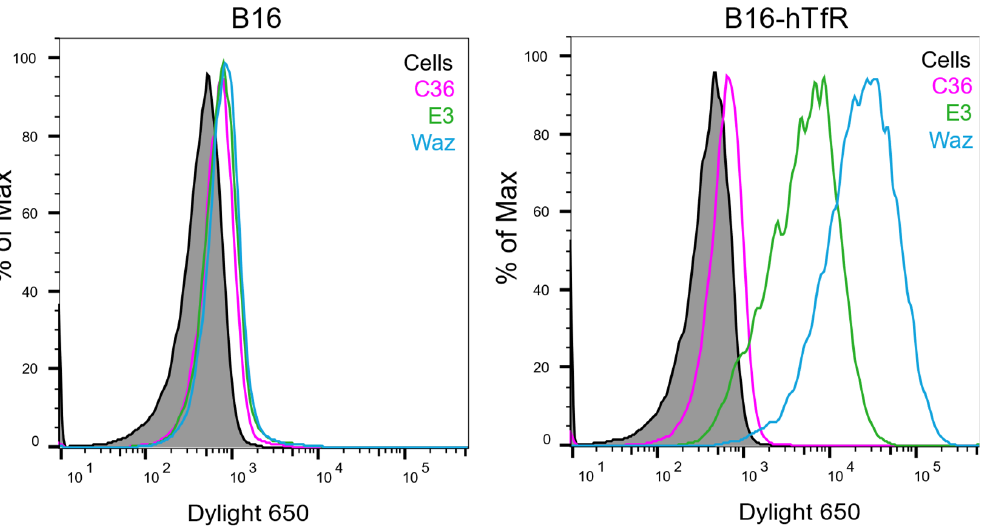
Figure 3. Binding signals on B16 ( left ) and hTfR-expressing B16 cells ( right ). The parental cell line (B16) was a murine melanoma cell line.